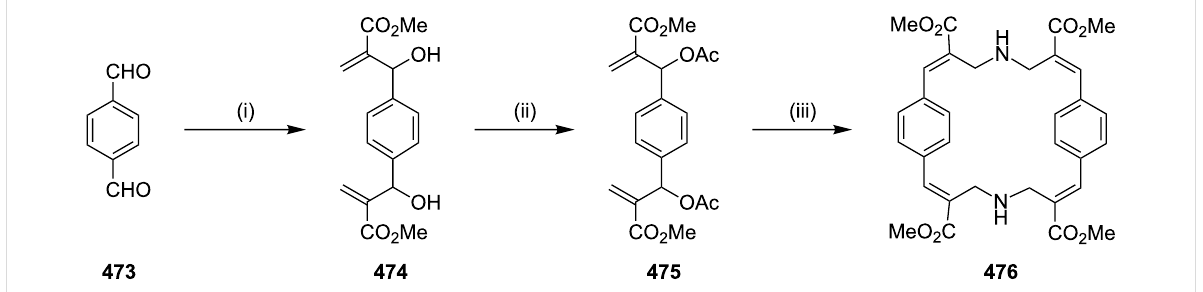
Figure 12: Cyclophanes 466–472 synthesized via Hofmann